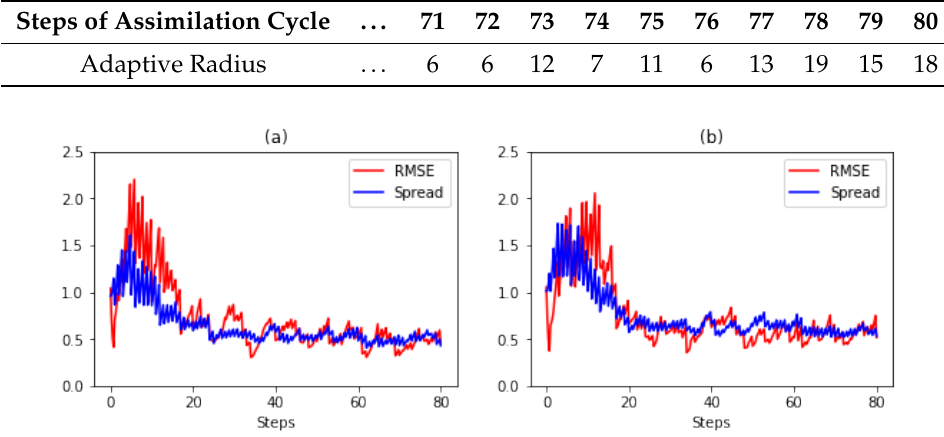
Figure 7. RMSE and spread with the ( a ) adaptive scheme and ( b ) fixed scheme tuned